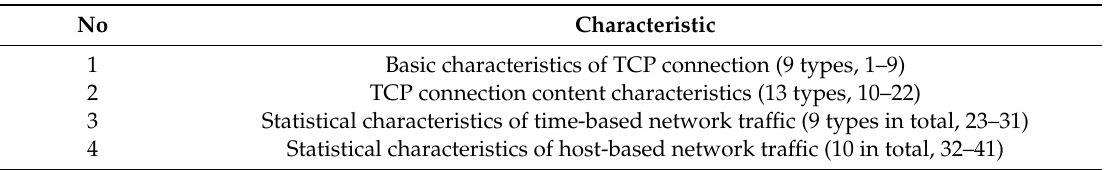
Table 3. The characteristics of NSL-KDD, which include four